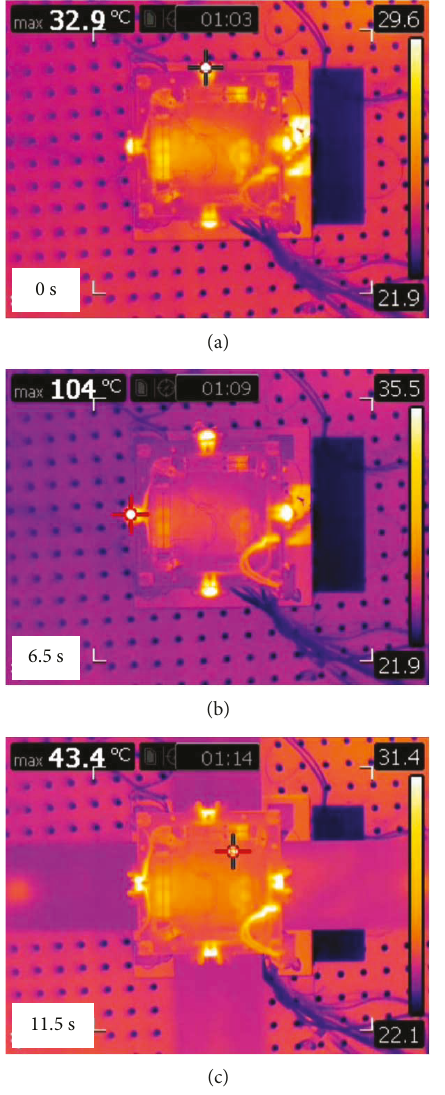
Figure 8: IR image taken at the maximum temperature of the burn resistor of the mechanism.